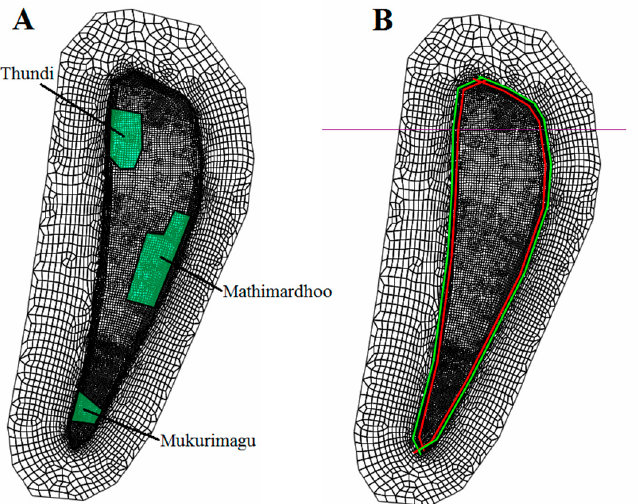
Figure 4. Finite element mesh used for the SUTRA model of Gan Island, showing ( A ) the collection of finite element nodes within each island village, and ( B ) the comparison of the island surface before (2012: green line) and after (2050: red line) sea level rise. The difference between the green and red lines indicates the island surface area that will be inundated by 2050.